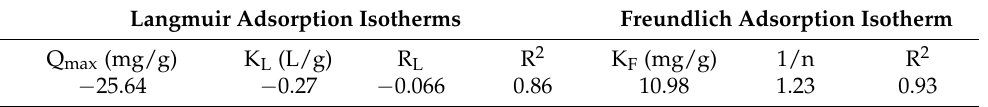
Table 2. Parameters for the adsorption of BG by F. benghalensis leaves powder.